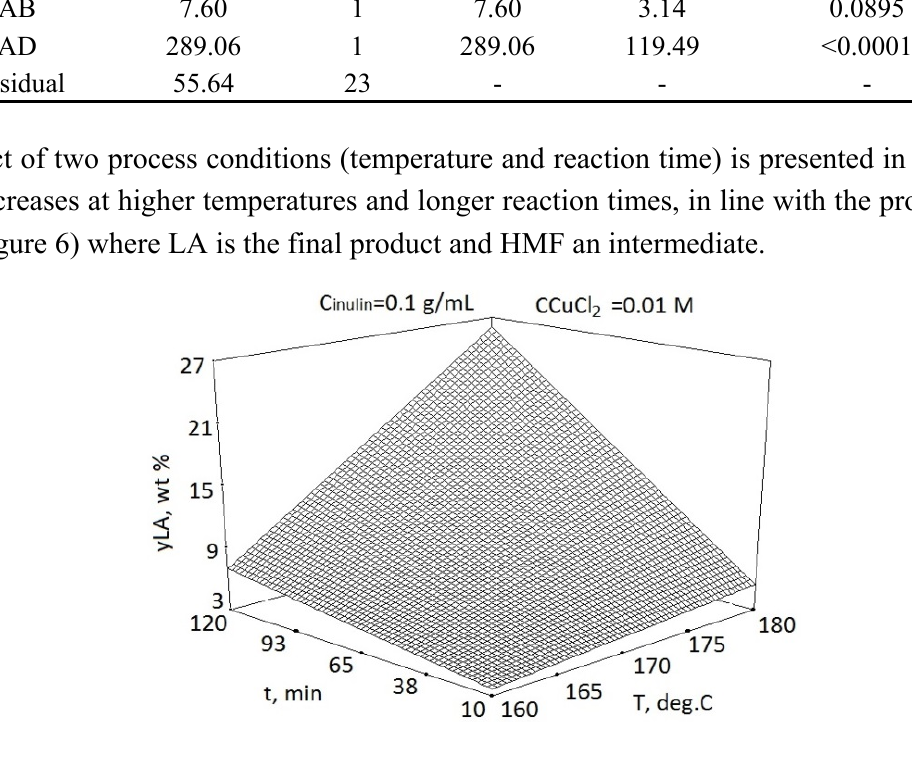
Figure 13. Modelled LA yield versus temperature and reaction time at a fixed inulin intake (0.1 g/mL) and CuCl 2 concentration (0.01